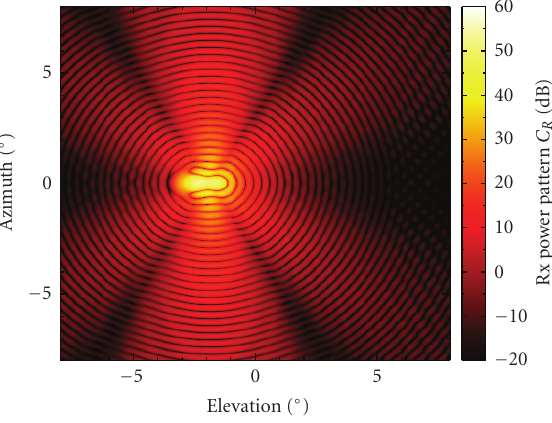
Figure 16: Receive power pattern with 5 elements